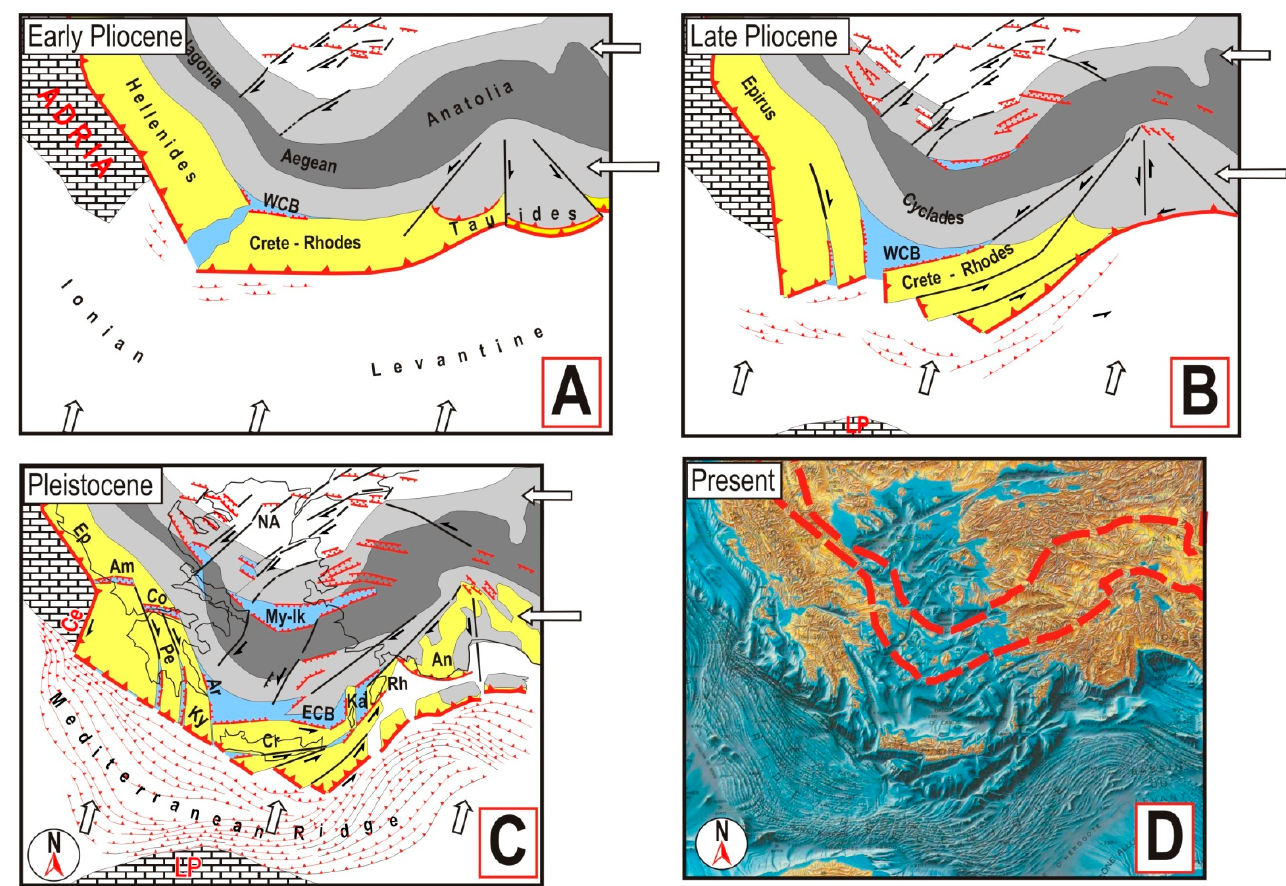
Figure 11. Tentative reconstruction of Aegean arc’s deformation pattern ( A – C ) and present mor- phological setting (( D ), modified from [191]). The red dashed lines in ( D ) tentatively delineate the shape of the inner Tethyan belt. Am—Ambracique trough; An—Antalya; Ar—Argolides trough; Co—Corinth trough; Cr—Crete; ECB—eastern Cretan basin; Ep-Epirus, Ka—Karpathos; Ky—Kythira slice; LP—Libyan promontory; My-Ik—Mykonos–Ikaria basin; NA—North Aegean; Pe—Peloponnesus; Rh—Rhodes; WCB—western Cretan basin. Symbols as in Figure 5.